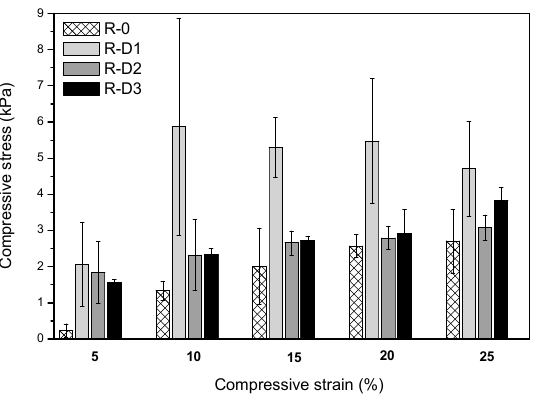
Figure 10. Compressive stress (at the selected strain) for charred intumescent coatings with PER-CNTs solid dispersions.